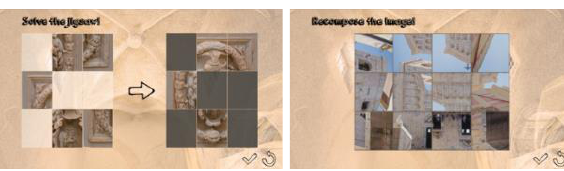
Figure 9 . Each puzzle provides historical information to be solved, in this case a multiple-choice quiz is shown.